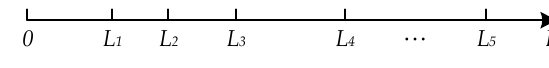
Figure 5. Time zone division.